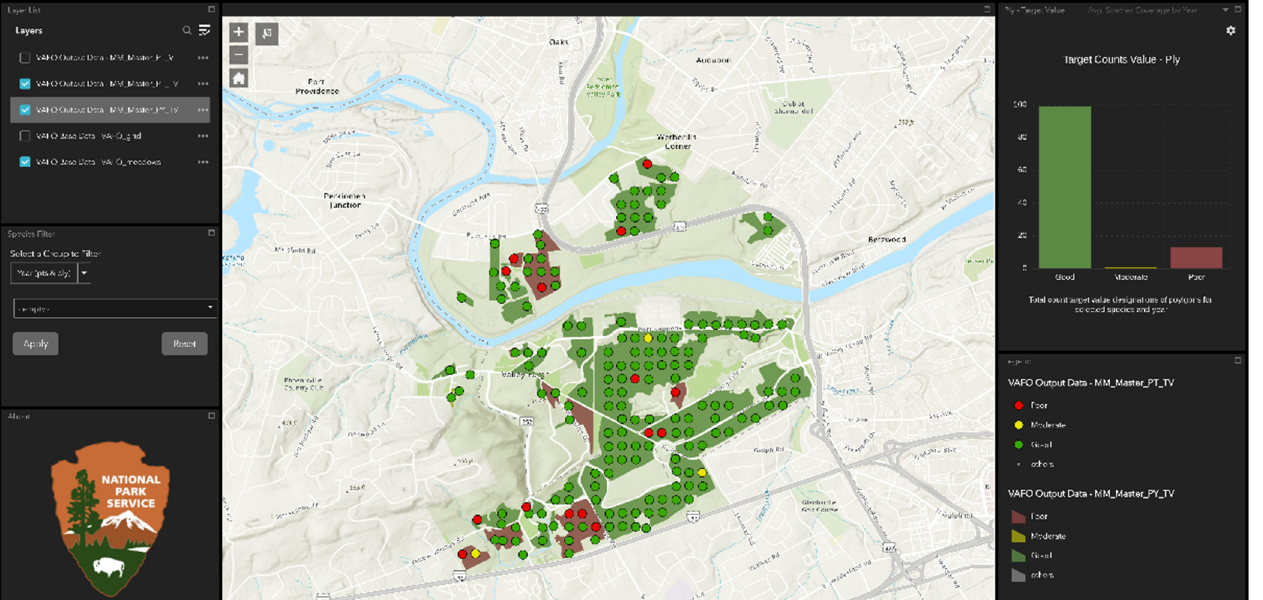
Figure 7. The GMMT online tool shows a representation of native species coverage benchmarks in point and meadow layers. The green represents points indicating “good” coverage/presence, while the red indicates “poor” coverage/presence. Benchmarks are user-defined (customizable) and vary by species or community. Top right shows the total count of points for each benchmark.